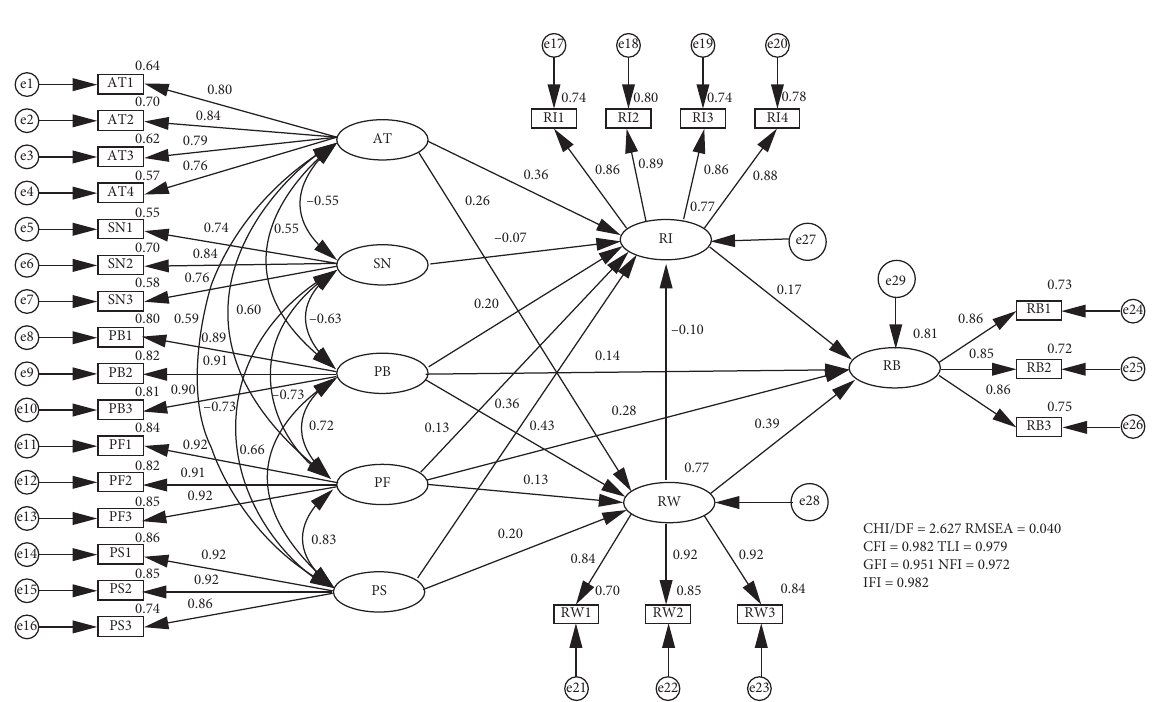
Figure 5: The modified PWM model for e-bikers’ RLR behavior.